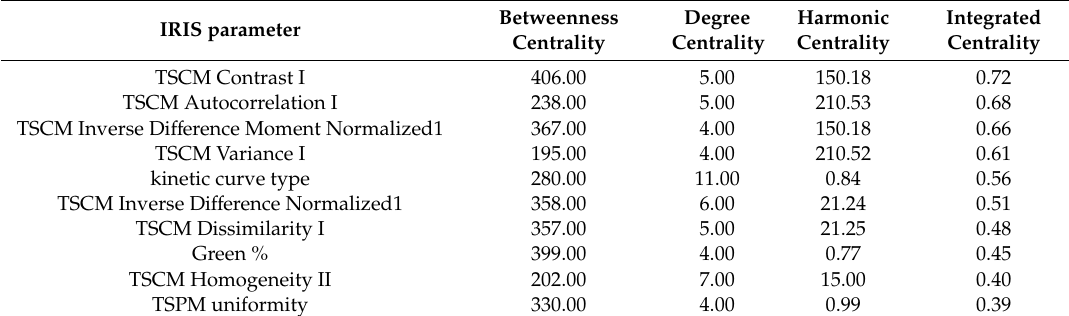
Table 6. Summary of centrality values across di ff erent IRIS parameters with mpRad. IRIS